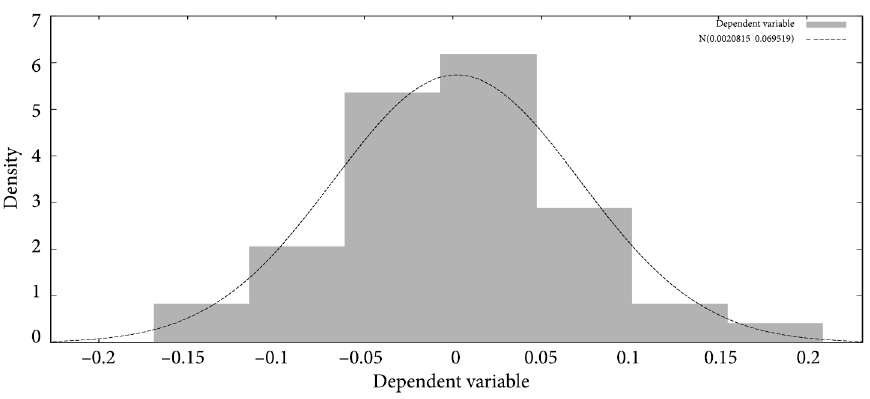
Figure 1. The normality of the residual (source: GRETL program) Test for null hypothesis of the normal distribution: Hi squared (2) = 1.077 with p-value